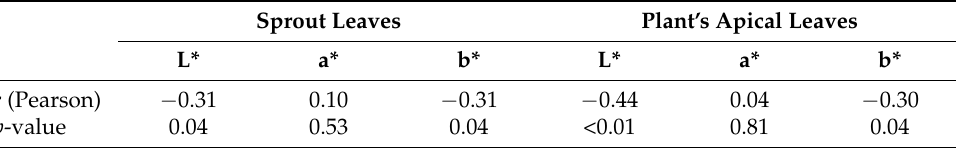
Table 4. Pearson correlation test (r) values between the colorimetric parameters (L*, a* and b*) and the B. tuberculata nymph density present in sprout leaves and superior third portion leaves, from nine cassava cultivars. Londrina. Paran á . Sprout Leaves Plant’s Apical Leaves L* a*